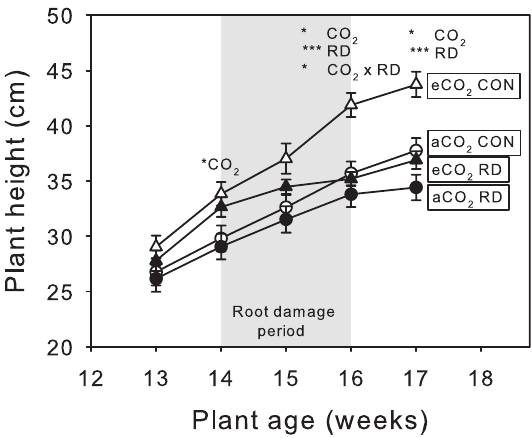
Figure 1. Plant height as affected by root damage and CO 2 . Height immediately preceding, during (shaded grey) and after root damage (RD) on plants under aCO 2 (circles) and eCO 2 (triangles). Open symbols are control plants (CON), closed symbols are plants with insect root damage (RD). Mean values 6 S.E. shown, N=24. Statistical significance of treatments indicated *( P , 0.05), **( P , 0.01) and ***